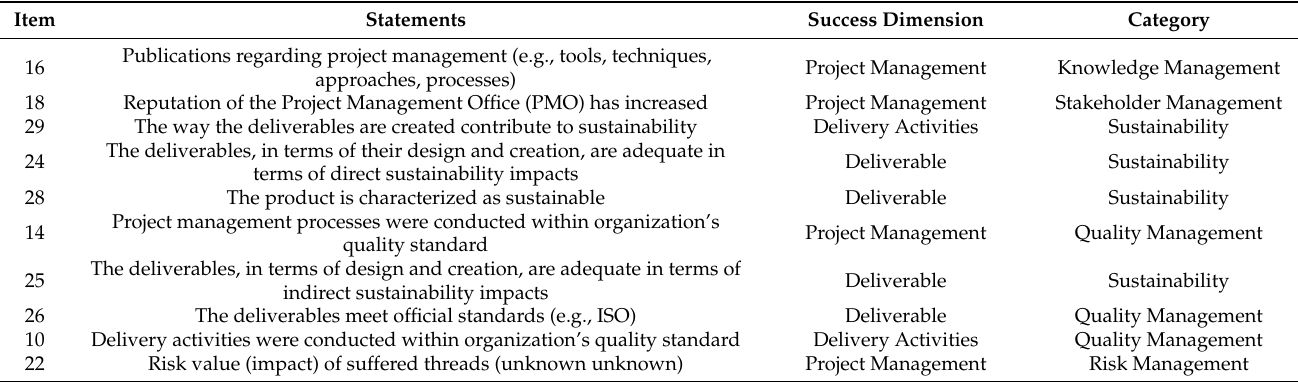
Table 11. Bottom-ranked statements for stakeholders and the